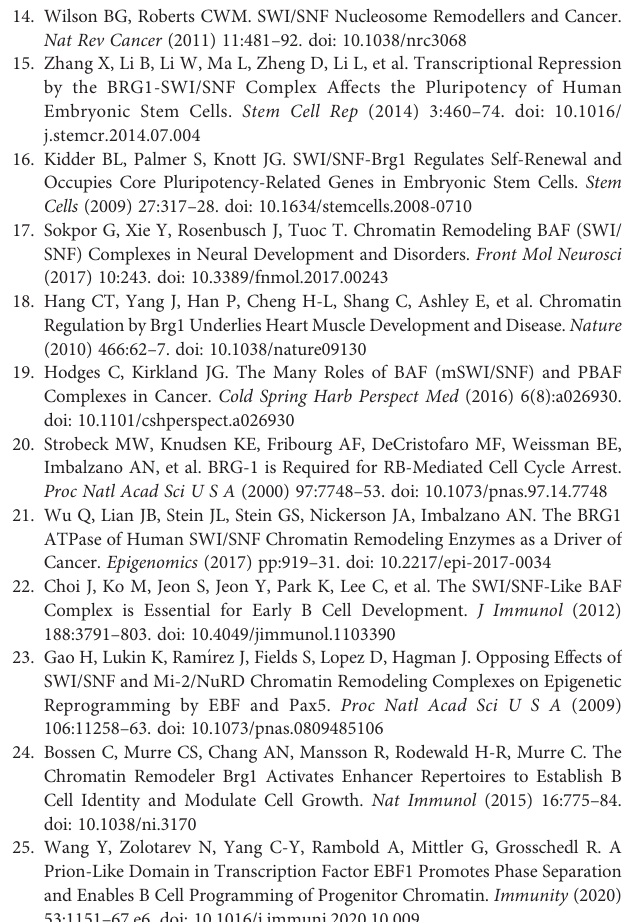
Supplementary Figure 1 | Brg1 is required for proper expression of cell-cycle- related genes in LPS-stimulated B cells. (A) Western Blot analysis for Brg1 protein levels in splenic B cells of littermate and Brg1 fl / fl CD23-Cre mice. B cells were activated for 4 days with LPS and IL-4. b -Actin serves as loading control. (B, C) Flow cytometric analysis of the live-dead marker 7-AAD as well as B cell activation marker CD86 after 18 hours of activation with LPS and IL-4. Background staining was determined from CD86-PE on B220-negative splenic cells (non-B cells). (D) UCSC genome browser tracks showing the loci of E2f8, which was signi fi cantly downregulated in CD23-Cre Brg1 fl / fl B cells, and Bach2, which was signi fi cantly upregulated in CD23-Cre Brg1 fl / fl cells. Tracks show the expression levels of the genes, measured by RNA-seq, in activated B cells from littermates, CD23-Cre Brg1 fl /+ , and Brg1 fl / fl mice, and ChIP-seq signal of Brg1 in resting and activated B cells, compared to input control. Green highlight: binding of Brg1 in the promoter regions. Orange highlights: 3 ’ end exons covered by RNA-seq. rB cells, resting B cells. aB cells, activated B cells. (E) Gene set enrichment plots for Myc targets and E2f targets from the hallmark gene sets. (F) Expression levels of E2f4 and Myc, measured by RNA seq, in control samples, including CD23-Cre Brg1 fl / fl and littermate controls. Normalization of reading counts and calculation of p value weredoneusingDeseq2. (G) Boxplotsindicatingthemedian,quartiles,and5thand 95th percentiles of mean Brg1 coverage across all FAIRE-seq and STARR-seq peaks in resting B cells. P values were calculated by a two-sided Wilcoxon rank- sum test. (H) Boxplots indicating the median, quartiles, and 5th and 95th percentiles ofmean Brg1coverage acrossallenhancersbinding 1-4 promoters and enhancers binding more than 4 enhancers, in resting and activated B cells. P values were calculated by a two-sided Wilcoxon rank-sum test. (I) Venn diagram showing overlap between 5,841 ATAC-seq peaks overlapping activated B cells enhancers,